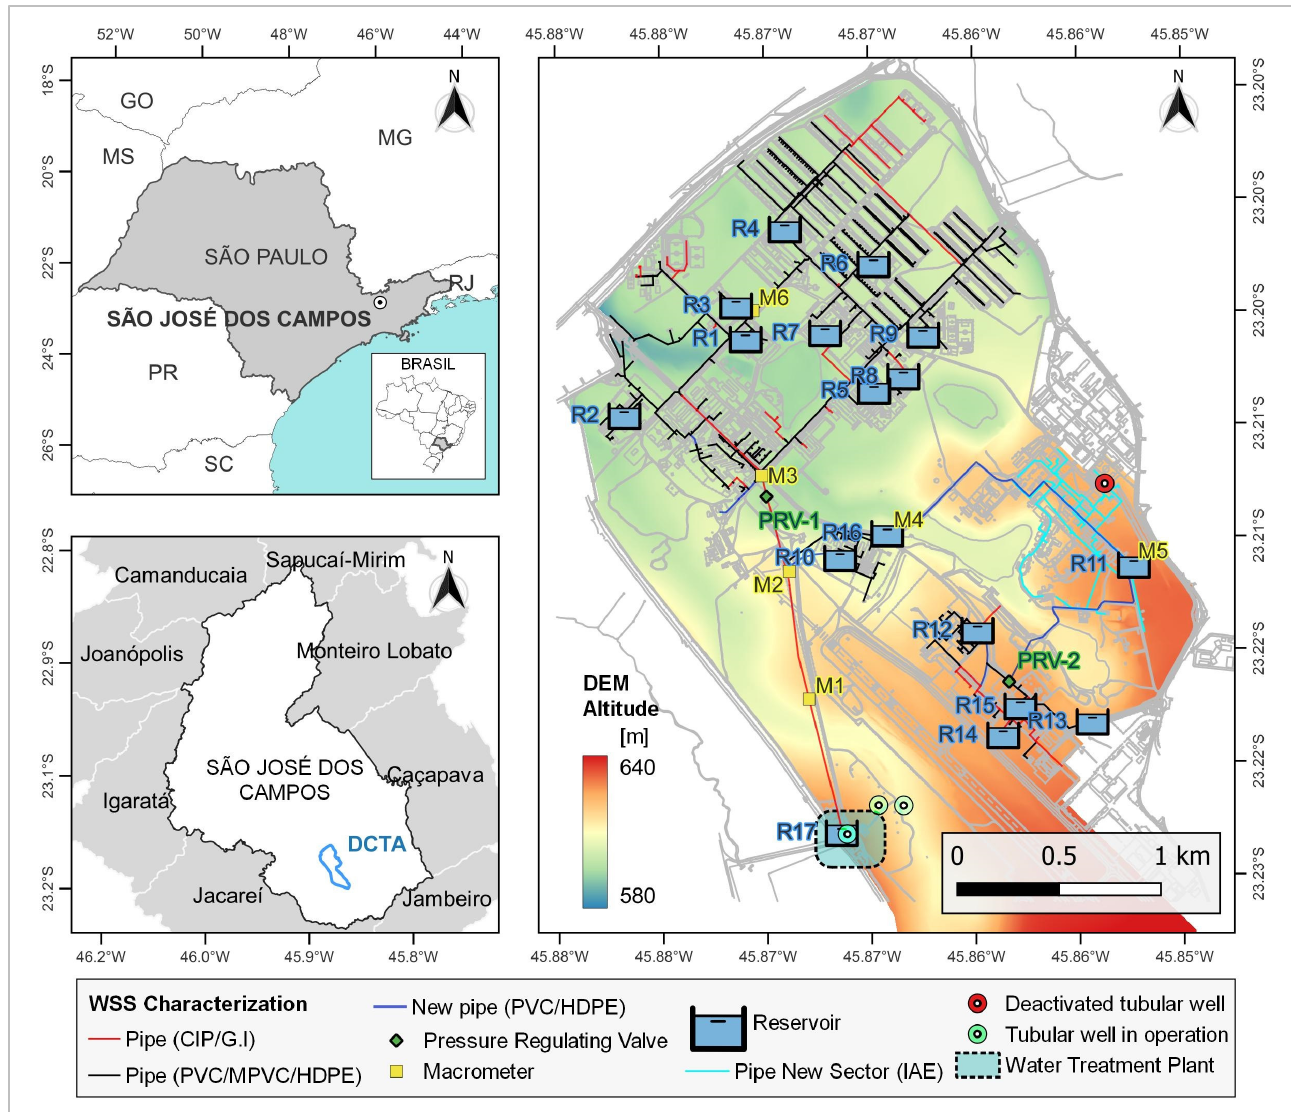
Figure 1. Location and characterization of the water distribution